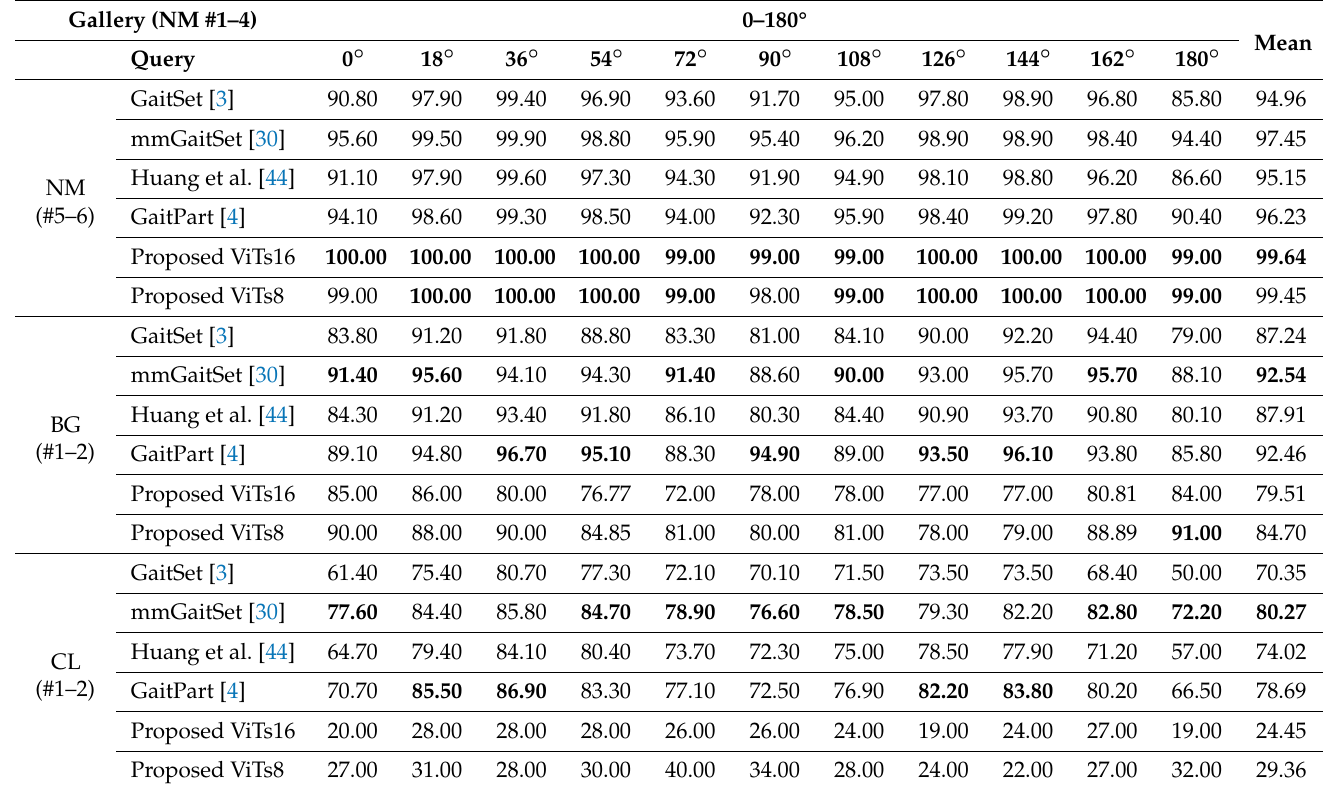
Table 3. Results for CASIA-B dataset LT setting. The best results for each angle and overall are in bold.